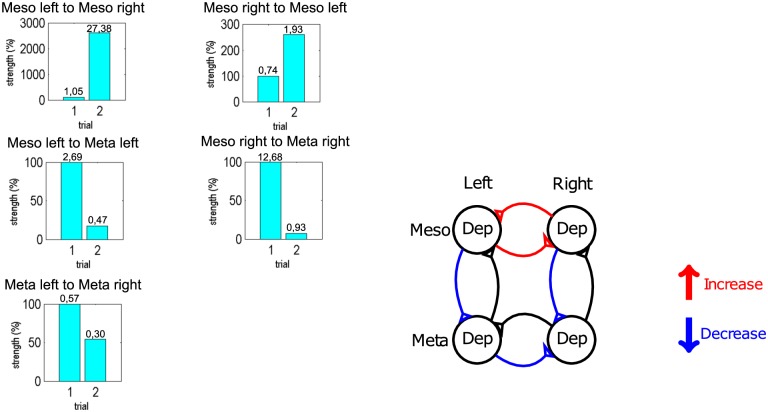
Second validation of DCM.Significant differences in connectivity from meso-meta thoracic connected segments (trial 1) to unconnected segments (trial 2). Left: Changes of connectivity strength, with trial 1 normalized to 100% coupling strength, absolute values of coupling strengths can be found on top of each bar; Right: Changes of connectivity compared to trial 1, red lines mark an increase in connectivity, blue lines a decrease in connectivity and black lines no reliable connectivity change (above 70%).